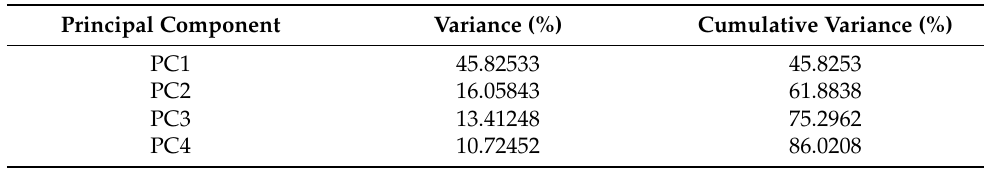
Figure 6. Pyrolytic compounds in the liquid fraction attained from untreated and H 2 SO 4 (0.1 wt%) washed coffee husks after fast pyrolysis at: ( a ) 400 °C; ( b ) 500 °C; ( c ) 600 °C. Symbols: untreated biomass; treated biomass. Table 2. Percentage of explained variance of the PCA